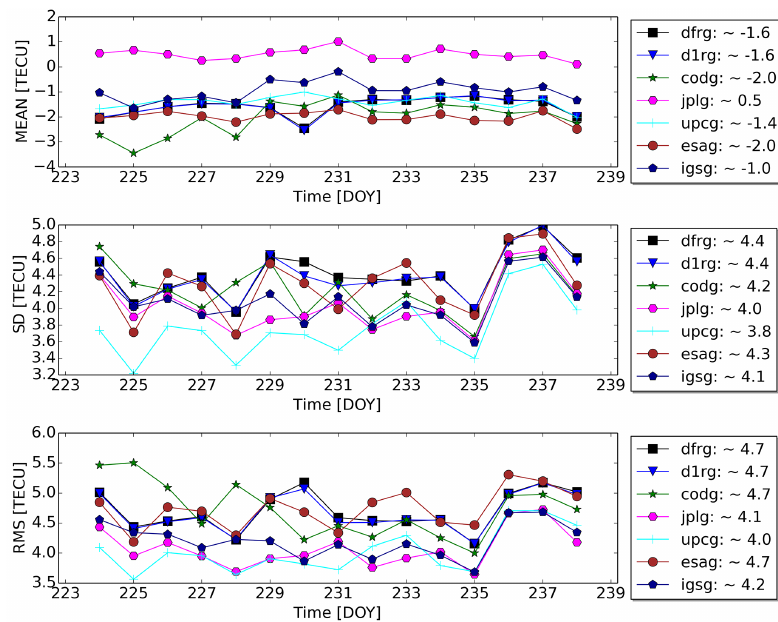
Figure 10. Comparison of VTEC values acquired from the analysis centers and the DGFI-TUM solutions with Jason-2 altimetry VTEC data between DOY 224 and DOY 238, 2016; (upper panel) mean deviations, (middle panel) standard deviations and (bottom panel) RMS values of deviations in terms of